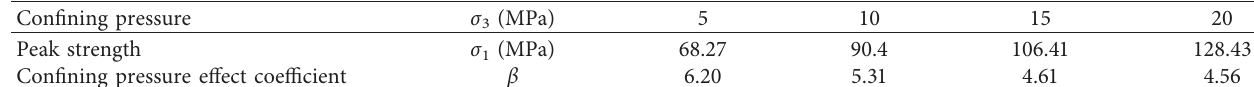
Table 6: Confining pressure effect